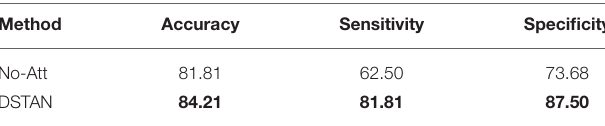
TABLE 3 | Comparing the classification performance of the DSTAN and the No-Att